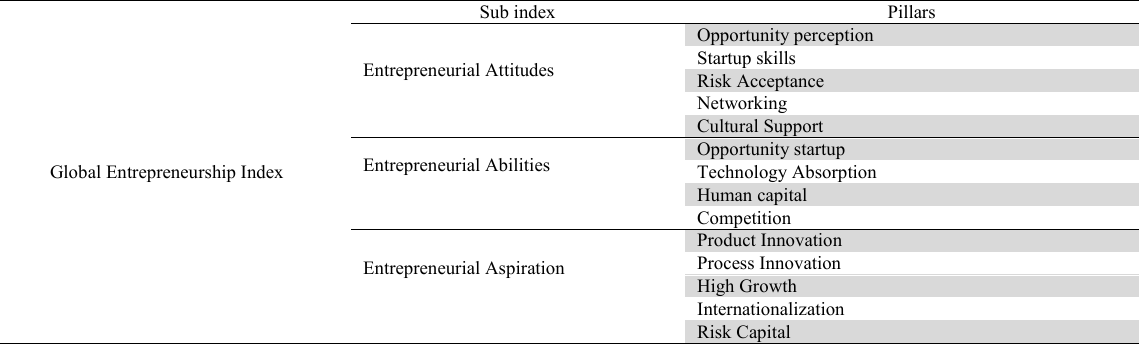
Elements of Global Entrepreneurship Index